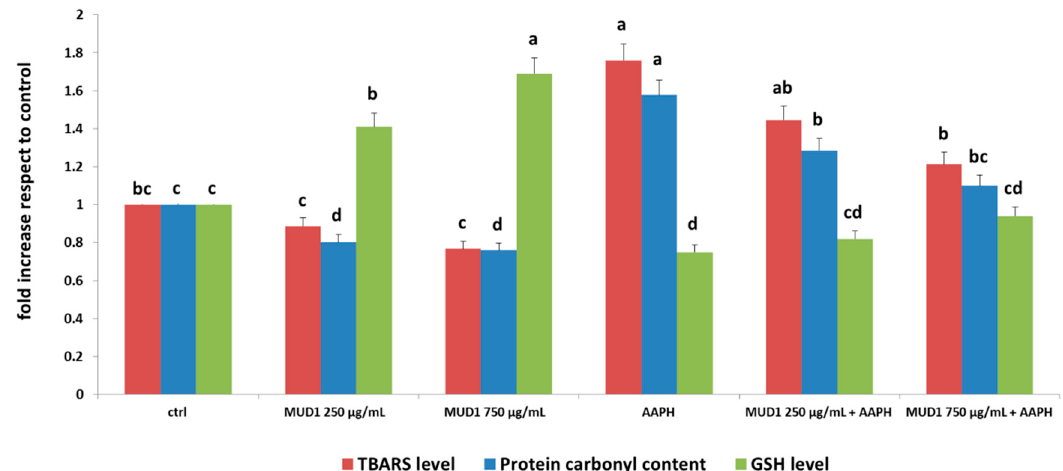
Figure 3. TBARS level (red bars), Protein carbonyl content (blue bars) and GSH (green bars) in HDF cells treated with different concentrations of MUD1 (250–750 µg/mL) for 24 h or AAPH (10 mM) for 24 h and with different concentrations of MUD1 and then with AAPH. Data are expressed as mean values ± SD. Columns with different superscript letters are significantly different ( p < 0.05).